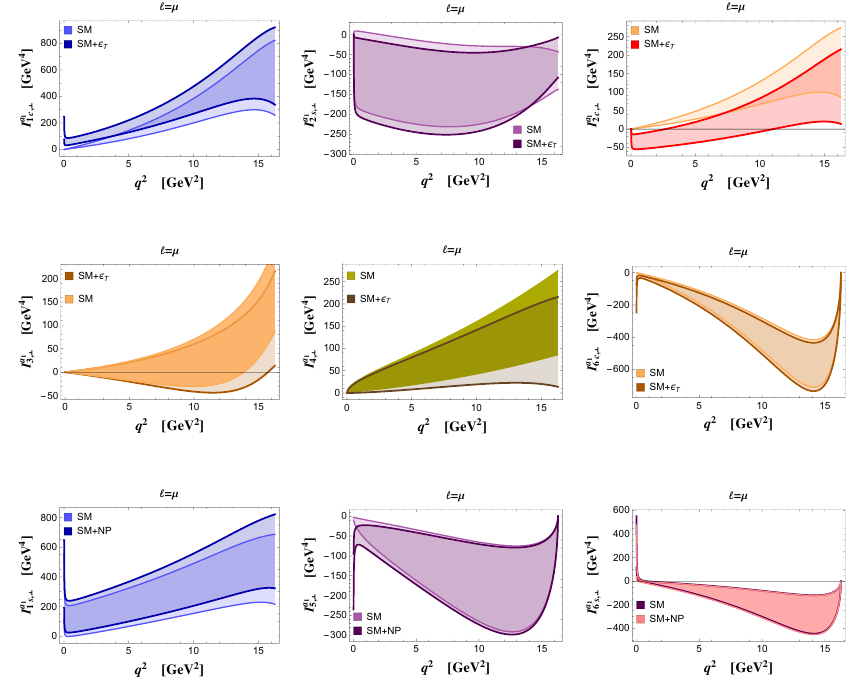
Figure 16. Angular coefficient functions for ¯ B → a 1 ( ρ ⊥ π ) µ − ¯ ν µ (same notations as in Figure 14).